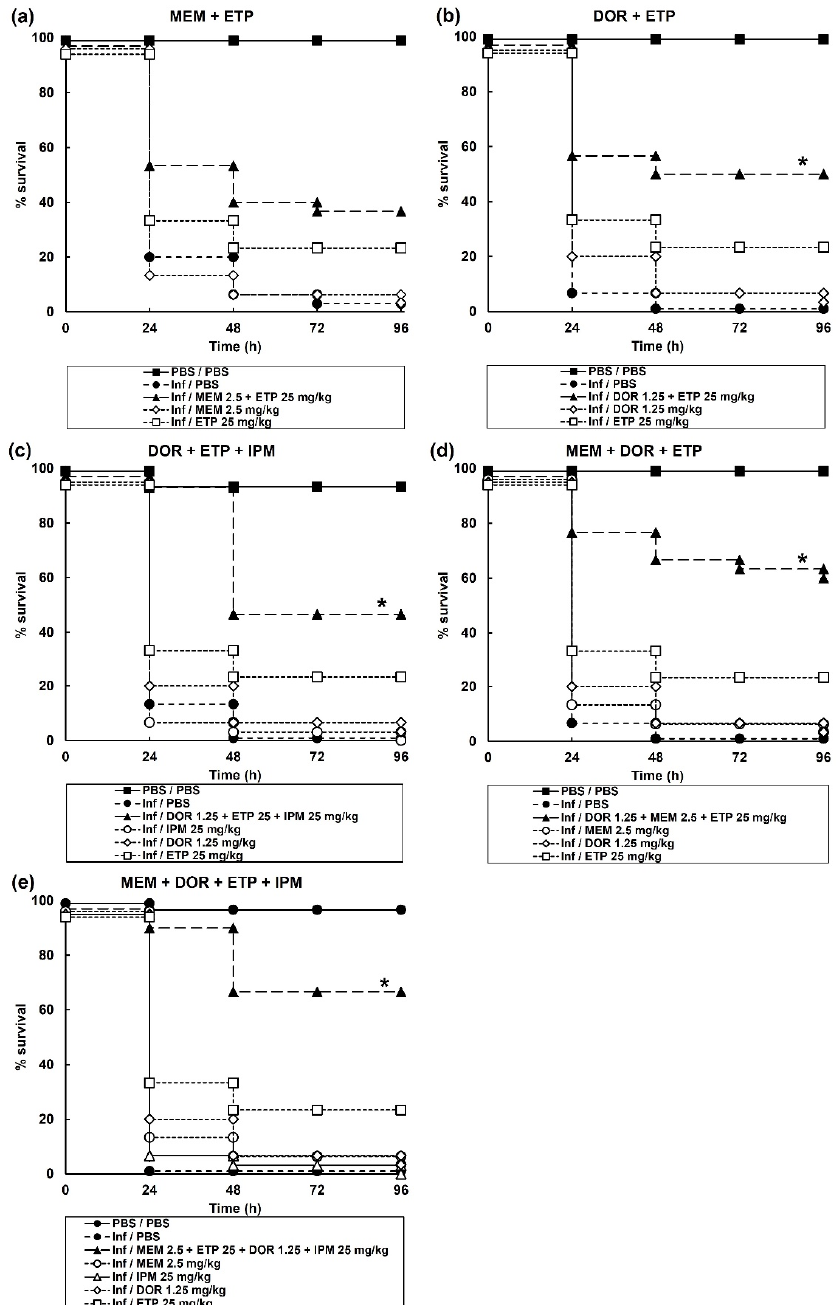
Figure 2. Effect of treatment with carbapenem monotherapies and dual, triple, and one quadruple combination on survival of G. mellonella larvae infected with 2.5 × 10 3 cfu/mL of P. aeruginosa NCTC13437. Infected larvae were treated with PBS (mock ‘treated’), carbapenem monotherapies, or carbapenem combinations: ( a ) MEM (2.5 mg/kg) + ETP (25 mg/kg); ( b ) DOR (1.25 mg/kg) + ETP (25 mg/kg); ( c ) DOR (1.25 mg/kg) + ETP (25 mg/kg) + IPM (25 mg/kg); ( d ) MEM (2.5 mg/kg) + DOR (1.25 mg/kg) + ETP (25 mg/kg); or ( e ) MEM (2.5 mg/kg) + DOR (1.25 mg/kg) + ETP (25 mg/kg) + IPM (25 mg/kg). A single dose of the antibiotic treatments was administered 2 h p.i and larvae were incubated at 37 ◦ C for 96 h. The uninfected group represents larvae sham-infected with sterile PBS and treated with sterile PBS. * Indicates significantly enhanced survival compared to each monotherapy alone ( p < 0.05, log rank test with Holm correction for multiple comparisons); n = 30 (pooled from duplicate